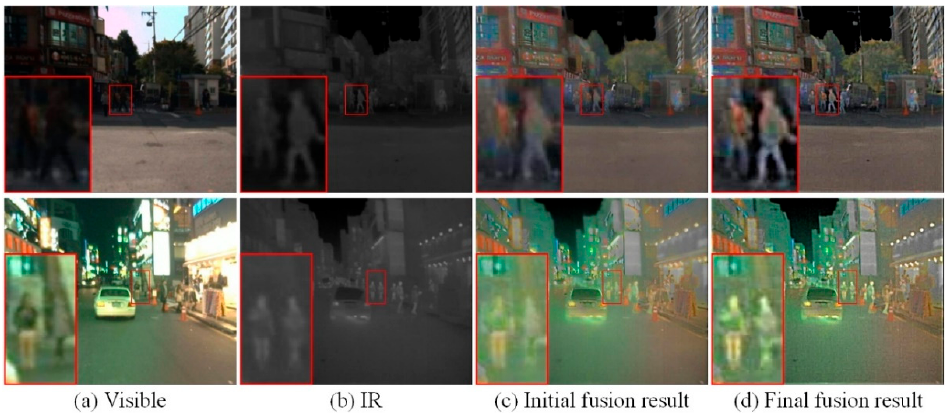
Figure 3. The fusion results of the proposed method. ( a ) shows the visible images; ( b ) shows the infrared images; ( c ) shows the initial fusion results without infrared detail enhancement; ( d ) shows the final fusion results with infrared detail enhancement.